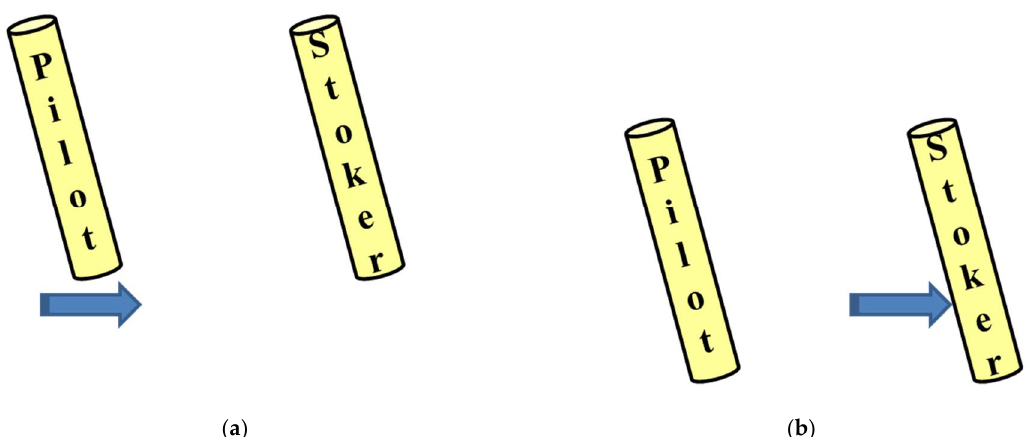
Figure 6. Schematics illustrating the flow around both legs at 0 degrees (Figure 5b). The wind direction is from the left to the right. ( a ) both riders’ legs are at the top; ( b ) both riders’ legs are at the bottom.